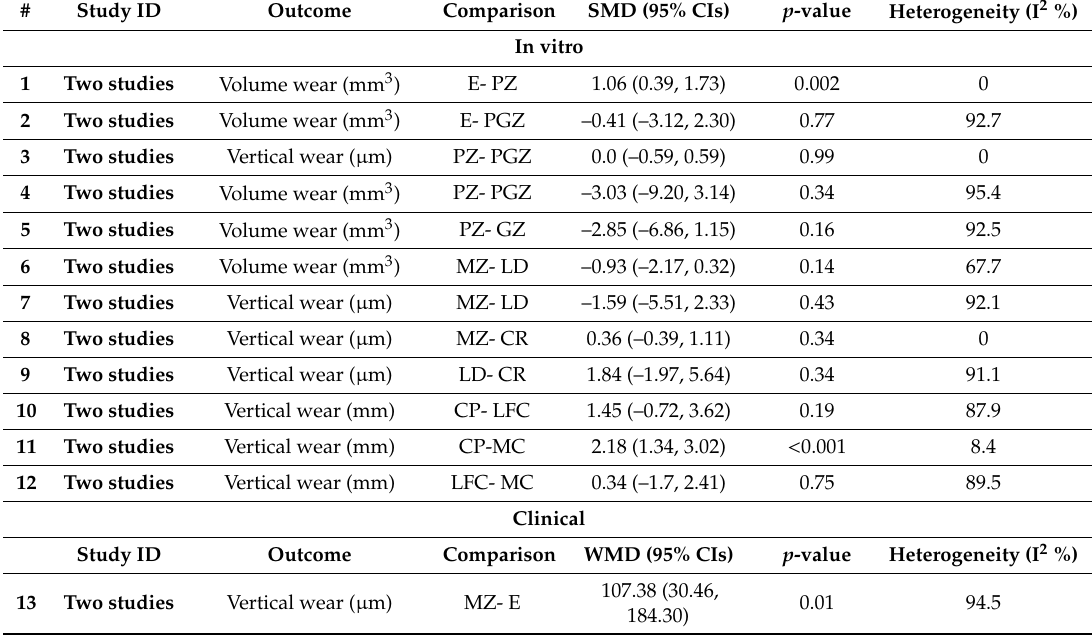
Table 3. Quantitative syntheses for enamel wear related to eligible outcomes / comparisons across in vitro and clinical